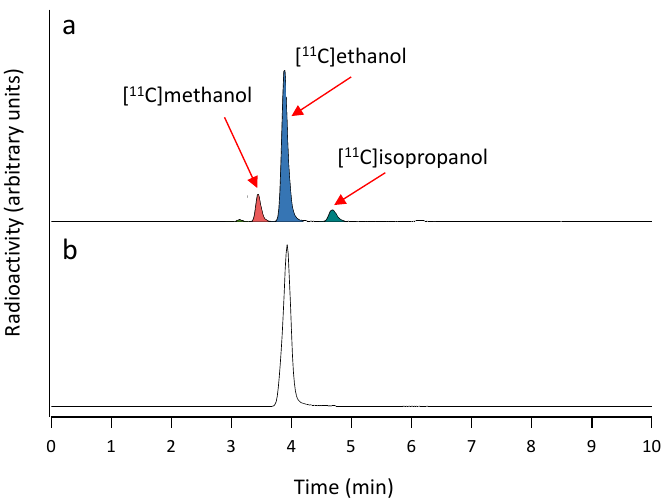
Figure 7. ( a ) Chromatograms (radioactivity detector) obtained after analysis of the reaction crude; ( b ) chromatograms (radioactivity detector) obtained in quality control analysis of the purified 1- 11 C-ethanol. Lung PET Studies